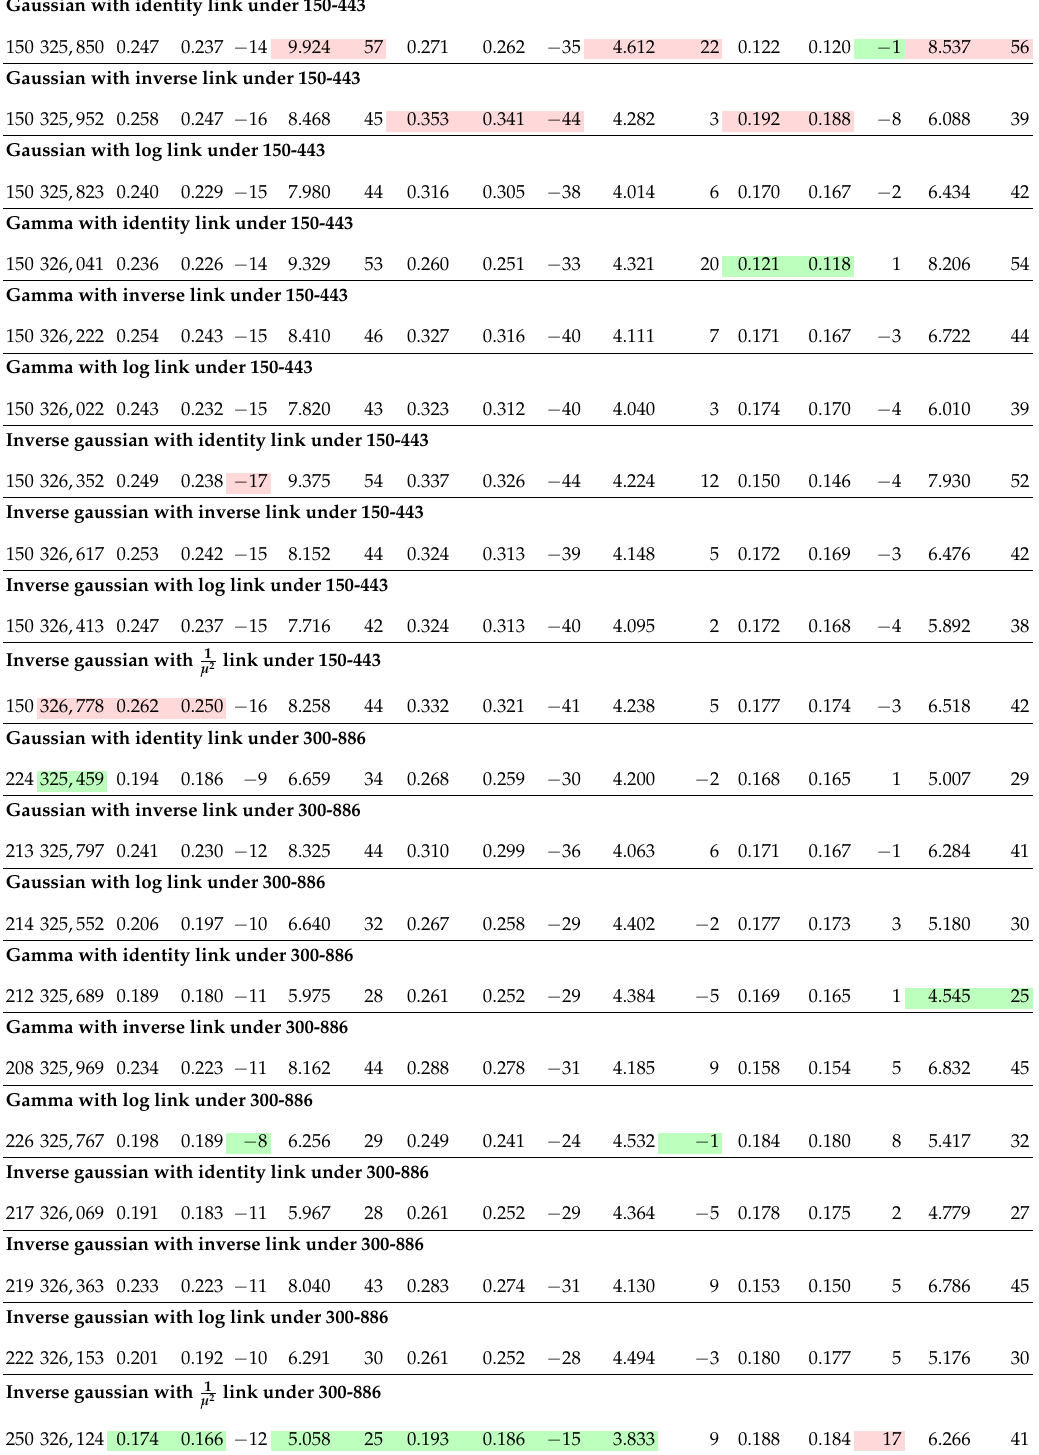
Table A14. AIC scores and out-of-sample validation figures of the gaussian, gamma and inverse gaussian GLMs of BEL with identity, inverse, log and 1 after the final iteration. Highlighted in green and red respectively the best and worst AIC scores and validation